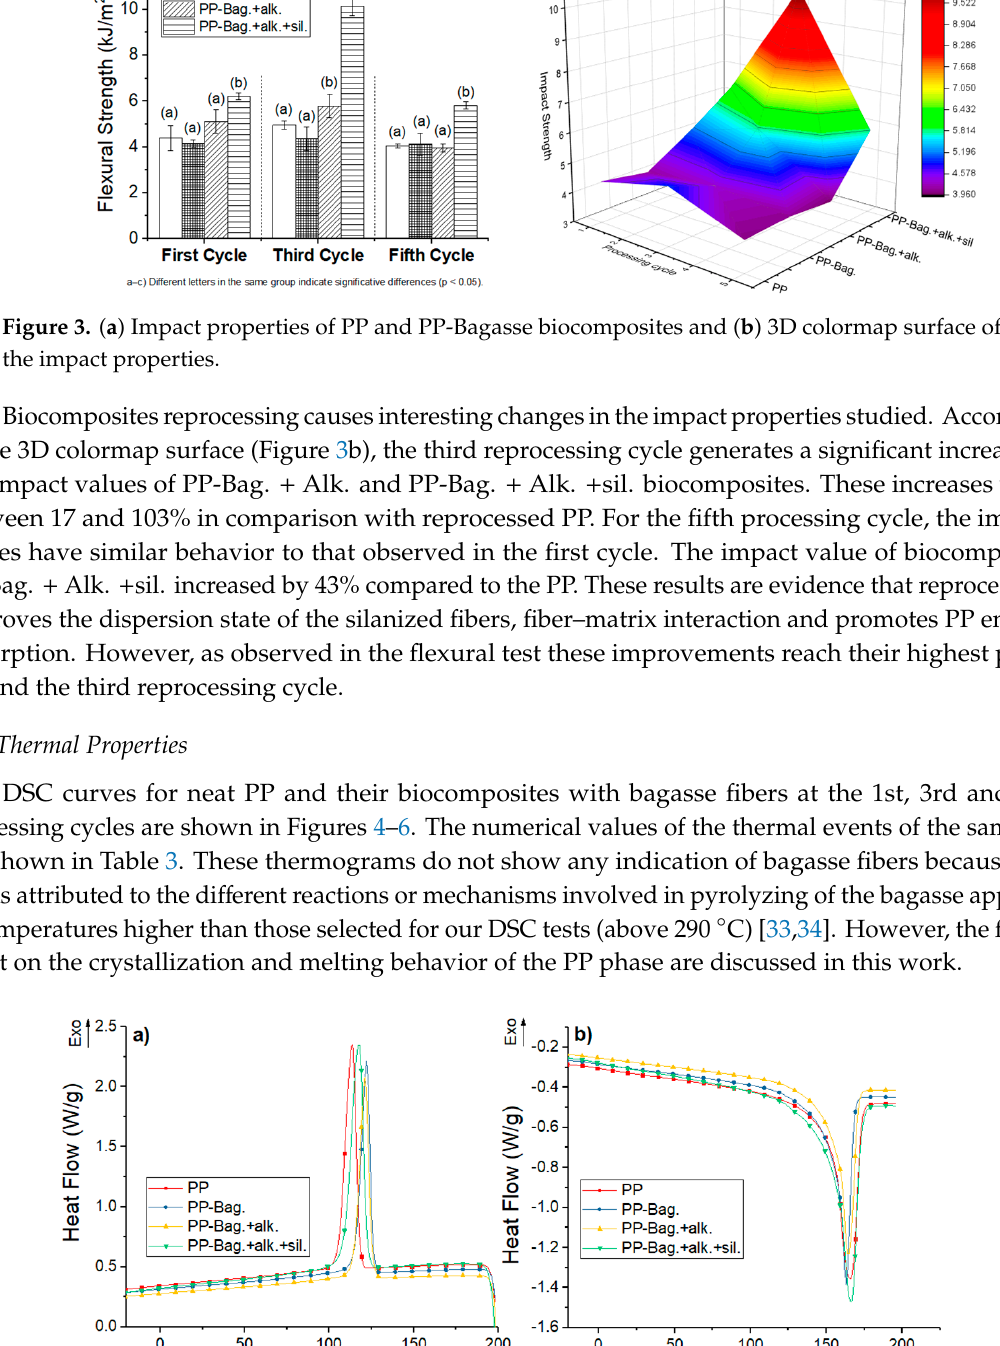
7 of 23 Figure 2. Three-dimensional colormap surface of flexural modulus ( a ) and flexural strength ( b ) of PP and PP-Bagasse biocomposites. The 3D colormap surface indicates that successive reprocessing cycles did not affect the flexural behavior of the PP. However, bagasse fibers addition and chemical treatments performed on these fibers generate improvements in the flexural properties of the PP matrix. Additionally, it is observed that flexural behavior of biocomposites are dependent on reprocessing cycles of the materials, reaching maximum values around the third cycle. With subsequent reprocessing, a decrease in flexural properties was observed. The first processing cycle shows the flexural modulus (FM) of biocomposites PP-Bag. and PP-Bag. + Alk, increased by 60% and 42% compared to neat PP. Additionally, flexural strength values (FS) increased by 20% and 8%, respectively. For biocomposite PP-Bag. +alk. +sil. FM value increased by 16%; however, no significant differences in the FS value were observed ( p ≥ 0.05). Cerqueira et al. investigated the effect of untreated bagasse addition on the flexural properties of PP and found that FM and FS values increased by 32% and 35% respectively [29]. These improvements in flexural properties due to the addition of natural fibers have been observed in long [30] and short fibers [31,32]. However, it is essential to remark that our study demonstrated that this effect was also generated with the addition of microfibers. For the third processing cycle, all FM and FS values of the biocomposites show significant differences compared to the FM value of the PP matrix. These increments were 57%, 48% and 38% for PP-Bag., PP-Bag. + Alk. and PP-Bag. +alk. +sil respectively. Additionally, FS values increased by 11%, 7% and 4% respectively. It is interesting to show that FM and FS values of the sample PP-Bag. +alk. +sil. increased by 15% and 7% in comparison with the first processing cycle values. This could be related to a better dispersion state of the silanized bagasse fibers within the PP matrix, the higher thermal stability of chemically modified fibers [6] and a better interaction fiber–matrix generated by the reprocessing cycles. For the last reprocessing cycle, FM values of the biocomposites show significant differences in comparison with the PP matrix ( p < 0.05); however, no significant differences were observed among the biocomposites. In the same way, the FS values of the samples were statistically equivalent. These results show that reprocessing could improve fiber dispersion and improve fiber–matrix interaction under compression stresses developed in the biocomposites during bending. However, these